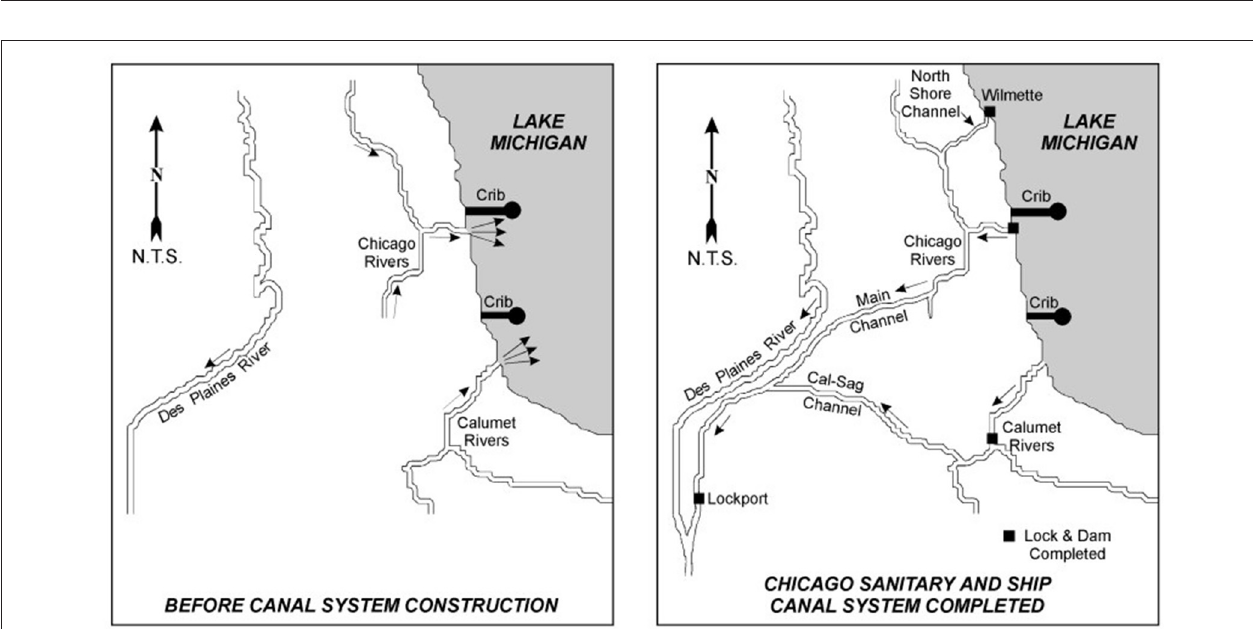
FIGURE 4 | Before and after diagram of the Chicago diversion based on the completion of the canal system [source: United States Army Corps of Engineers